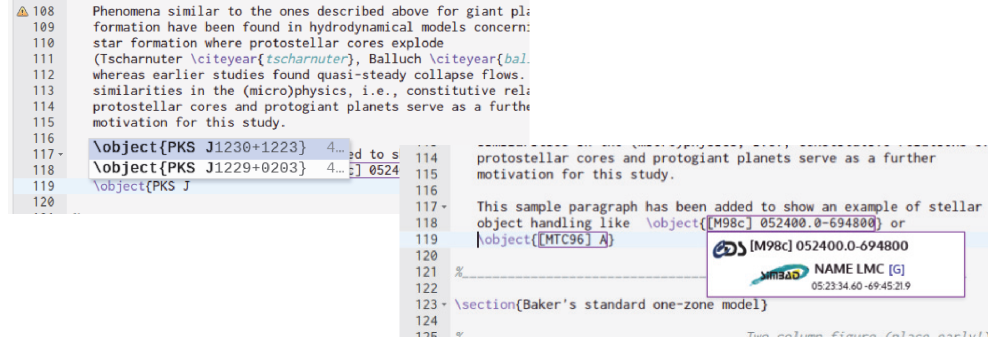
Figure 2. The many contributors to the Gaia Data Release 1.